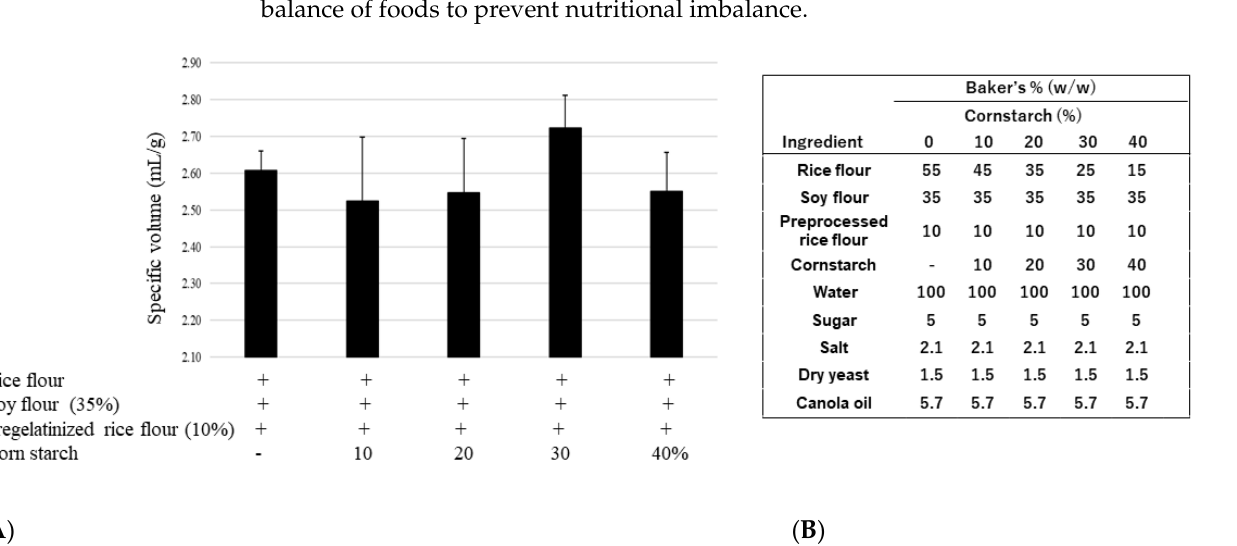
Figure 2. ( A ) Effect of soy flour substitution amount on the specific volume of bread; ( B ) Recipes for soy rice bread with preprocessed rice flour. Data are shown as mean ± SD. Different letters in- dicate p < 0.05 between groups.